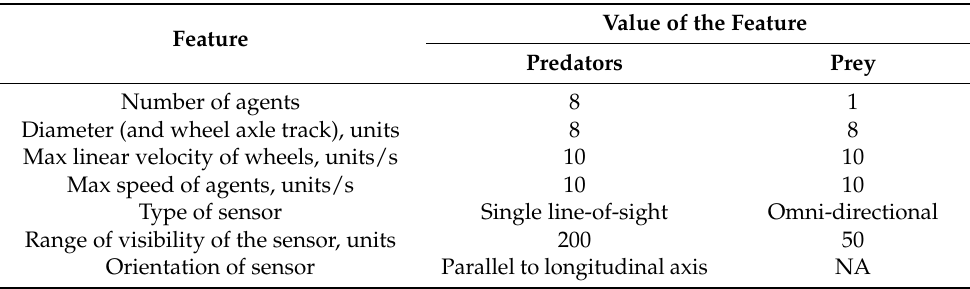
Table 1. Features of the predator and prey agents.